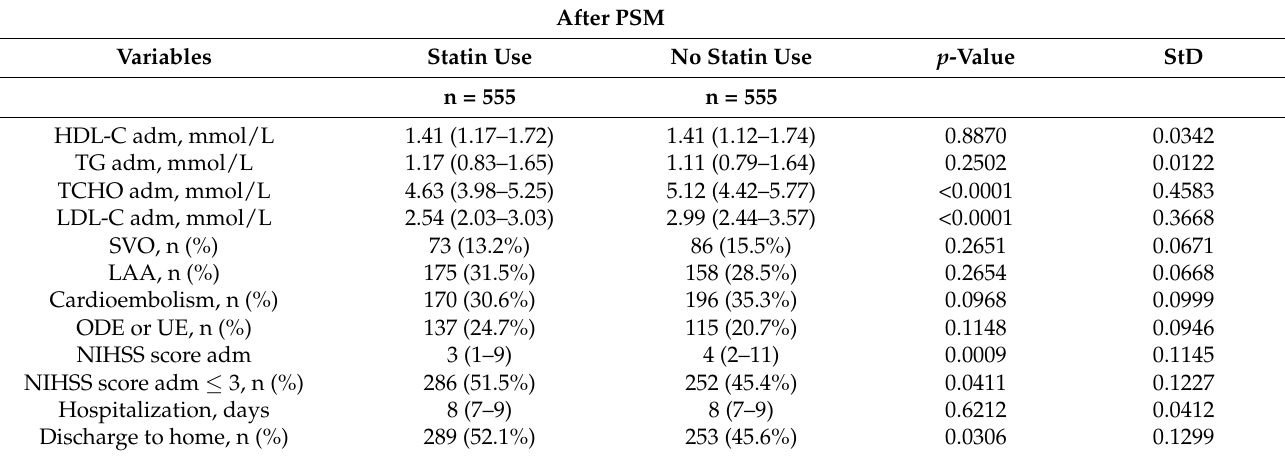
Table 3. Comparison of variables between the matched pairs after propensity matching (n = 1110). After